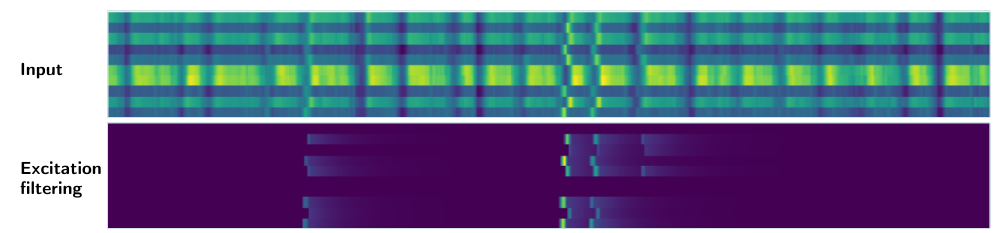
Figure 4. Post-processing of the similarity scores generated by the pre-trained embedder. The first matrix, denoted as input , shows an example of raw distances between the embeddings of keyword patterns and recording fragments. Each row corresponds to a single pattern, while each column represents a single time step. Brighter colours indicate smaller distances (closer matches). The second matrix shows the same values after row-wise standardisation and filtering through the exciter